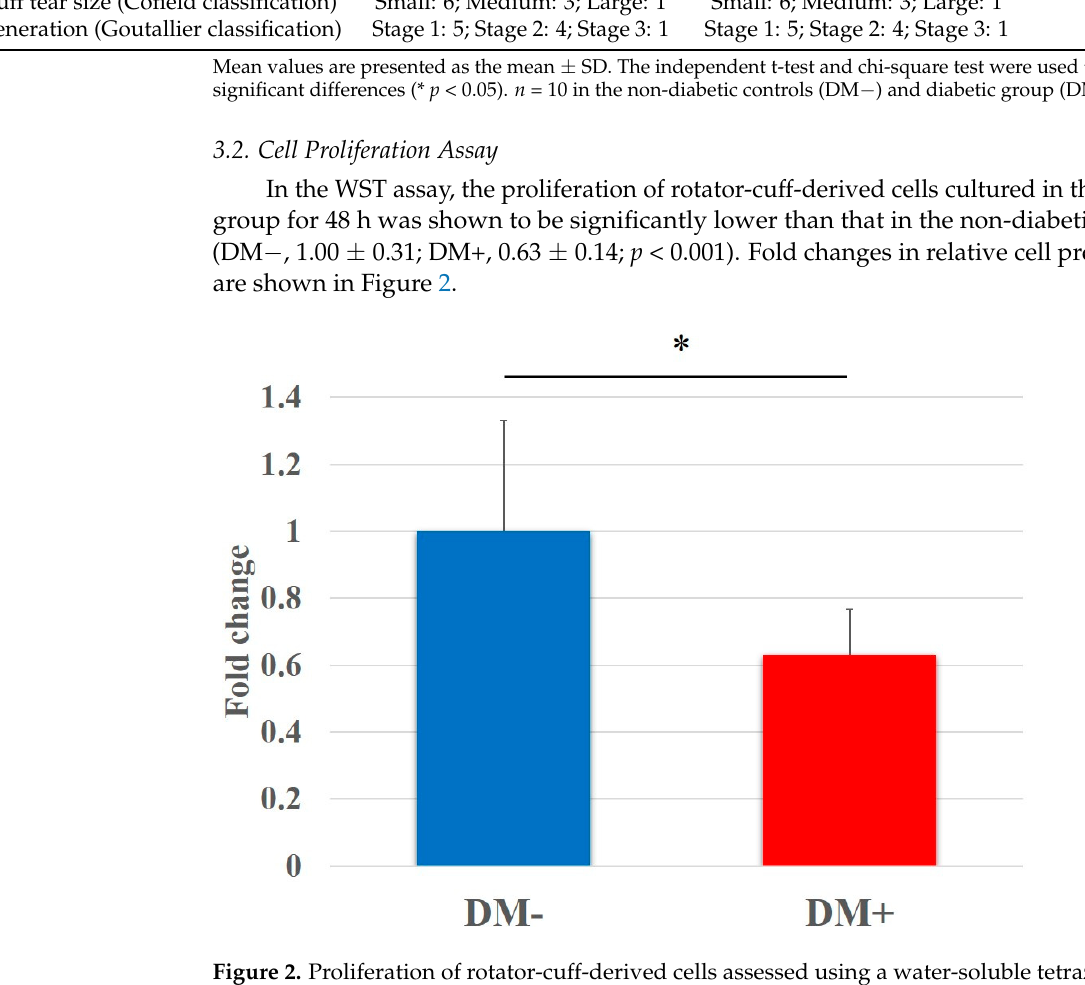
Table 2. Patient background characteristics.